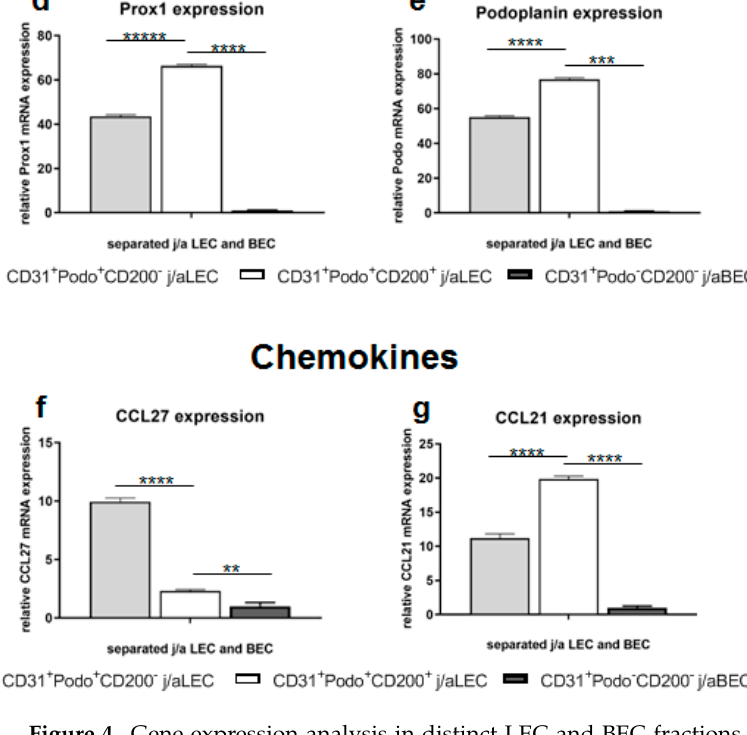
Figure 4. Gene expression analysis in distinct LEC and BEC fractions. HDMEC were harvested from j/a skin, cultured, separated at P0 into CD200 − /CD200 + LEC and CD200 − BEC fractions and used directly for qRT-PCR. The relative gene expression levels were normalized to GAPDH housekeeping gene and displayed relative to CD200 − BEC samples. ( a – c ) Analysis of adhesion molecules confirmed 11-fold upregulation of CD200 mRNA in j/aCD200 + LEC (31.70 ± 0.67) as compared to j/aCD200 − LEC (2.88 ± 0.6; p < 0.0001) and j/aCD200 − BEC (1 ± 0.41; p < 0.0001) ( a ). Another adhesion molecule, CD157 was also enriched in j/aCD200 + LEC (4.44 ± 0.48) as compared to j/aCD200 − LEC (2.68 ± 0.54; p = 0.0107) and j/aCD200 − BEC (1 ± 0.5; p = 0.0003) ( b ). The expression of CD62P selectin mRNA was reduced in j/aCD200 + LEC (0.22 ± 0.09) in comparison to j/aCD200 − LEC (0.43 ± 0.35; p = 0.5773, ns) and j/aCD200 − BEC (1.0 ± 0.25; p = 0.0186) ( c ). ( d , e ) Assessment of mRNA expression of lymphatic markers. J/aCD200 + LEC showed upregulated expression of PROX1 (66.34 ± 0.74) and podoplanin (76.93 ± 0.77) as compared to j/aCD200 − LEC (PROX1: 43.55 ± 0.78, podoplanin: 55.13 ± 0.76; both p < 0.0001) and j/aCD200 − BEC (PROX1: 1 ± 0.41, podoplanin: 1 ±